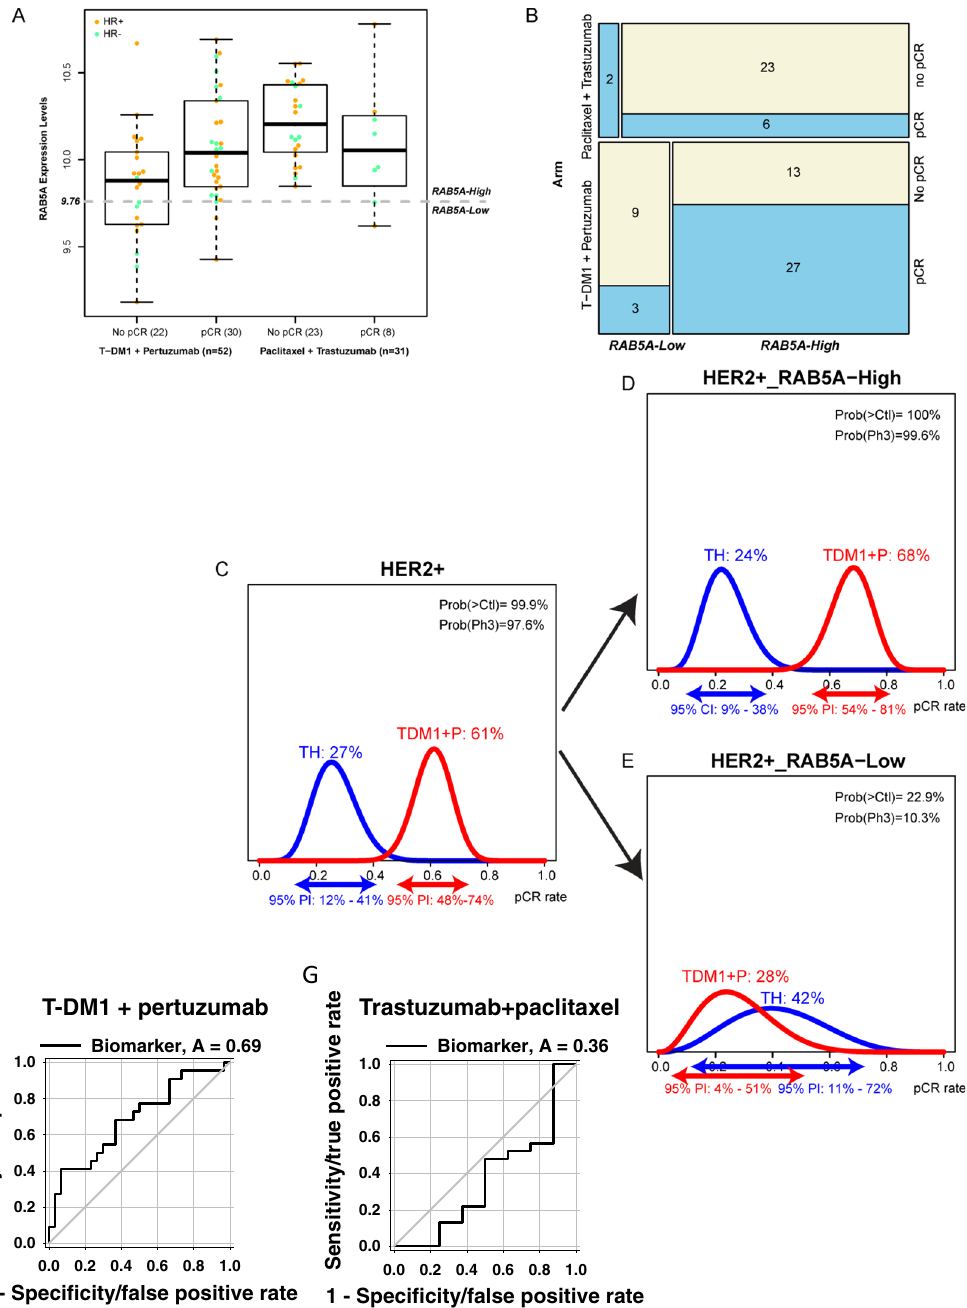
1 - Specificity/false positive rate Fig. 5 Patient distribution within pCR and RAB5A expression in I-SPY2. A Boxplots of RAB5A expression levels strati fi ed by arm and pCR status ( N = 83). The midline represents the median of RAB5 expression levels within each group (T-DM1 + pertuzumab-treated, no pCR: N = 22 independent samples; T-DM1 + pertuzumab-treated, pCR: N = 30 independent samples; trastuzumab + paclitaxel-treated, no pCR: N = 23 independent samples; trastuzumab + paclitaxel-treated, pCR: N = 8 independent samples). The upper and lower limits of the box correspond to the 1st and 3rd quartile of RAB5A expression, respectively, with whiskers extending to 1.5 times the interquartile range from top/bottom of the box. Dots represent expression values for each individual; and color re fl ects subtype (orange: HR + ; green: HR − ). B Mosaic plot showing patient distribution within the RAB5A RNA-high and -low based on the threshold of 9.76 by arm and pCR status. C – E The bayesian estimated pCR rates within the two treatment groups overall ( C ) as well as when divided in RAB5A RNA-high ( D ) and low ( E ) subsets. F , G ROC curves of the performance of RAB5A RNA as a biomarker in T-DM1 + pertuzumab-treated ( F )- and trastuzumab + paclitaxel-treated ( G ) patients. Source data are provided as a Source Data fi shows boxplots of RAB5A expression levels strati fi ed by arm and groups in each arm is illustrated in Fig. 5B together with the pCR pCR status; based on a Monte-Carlo 2-fold cross-validation data. procedure as described in M&M, a normalized RAB5A RNA Using this optimal threshold, only 2 patients in the TH arm expression level of 9.76 was selected as a threshold (dotted gray (6%) had RAB5A levels <9.76 and are considered RAB5A low , as opposed to 23% (12/52) of the T-DM1 + P arm (Fig. 5B). This line). The patient strati fi cation into RAB5A high and RAB5A low